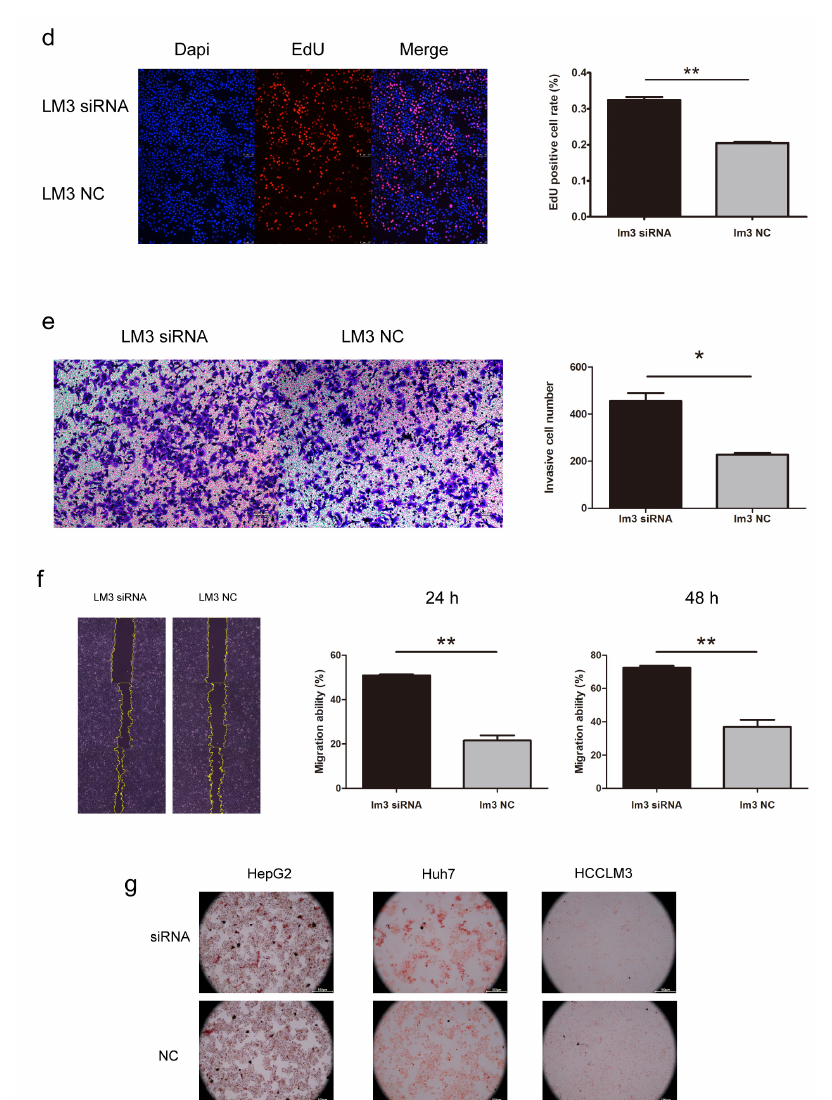
Figure 9. The expression and function of ADH1C in HCC. ( a ) Immunohistochemistry (IHC) staining of ADH1C in HCC and adjacent normal tissues. ( b ) The efficiency of siRNA targeting ADH1C. ( c , d ) CCK-8 and EdU assay indicated that ADH1C knockdown promoted proliferation of HCCLM3. ( e , f ) Transwell and the wound healing assay indicated that ADH1C knockdown promoted migration of HCCLM3. ( g ) Oil red O staining of HCC cell lines to check lipid droplets’ accumulation. * p < 0.05, ** p <